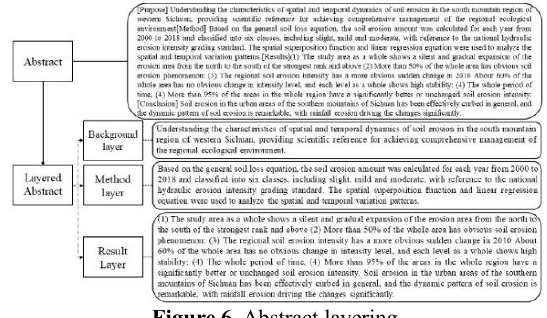
Figure 6 . Abstract layering.